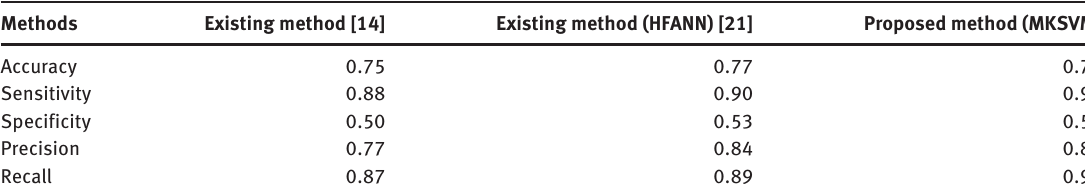
Table 4: Comparative Analysis of Proposed Performance.